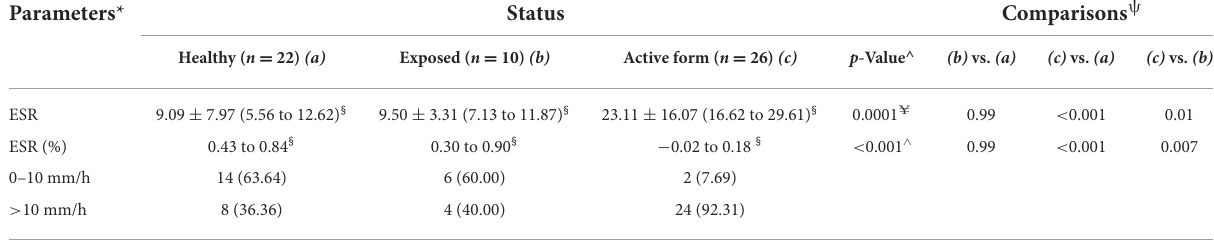
TABLE 1 Mean (M), standard deviation (SD), and confidential interval (CI) of erythrocyte sedimentation rate (ESR) as well as number and percentage of dogs with altered ESR level in healthy dogs, exposed dogs, and animals affected by a canine leishmaniosis (CanL) active form. Parameters *